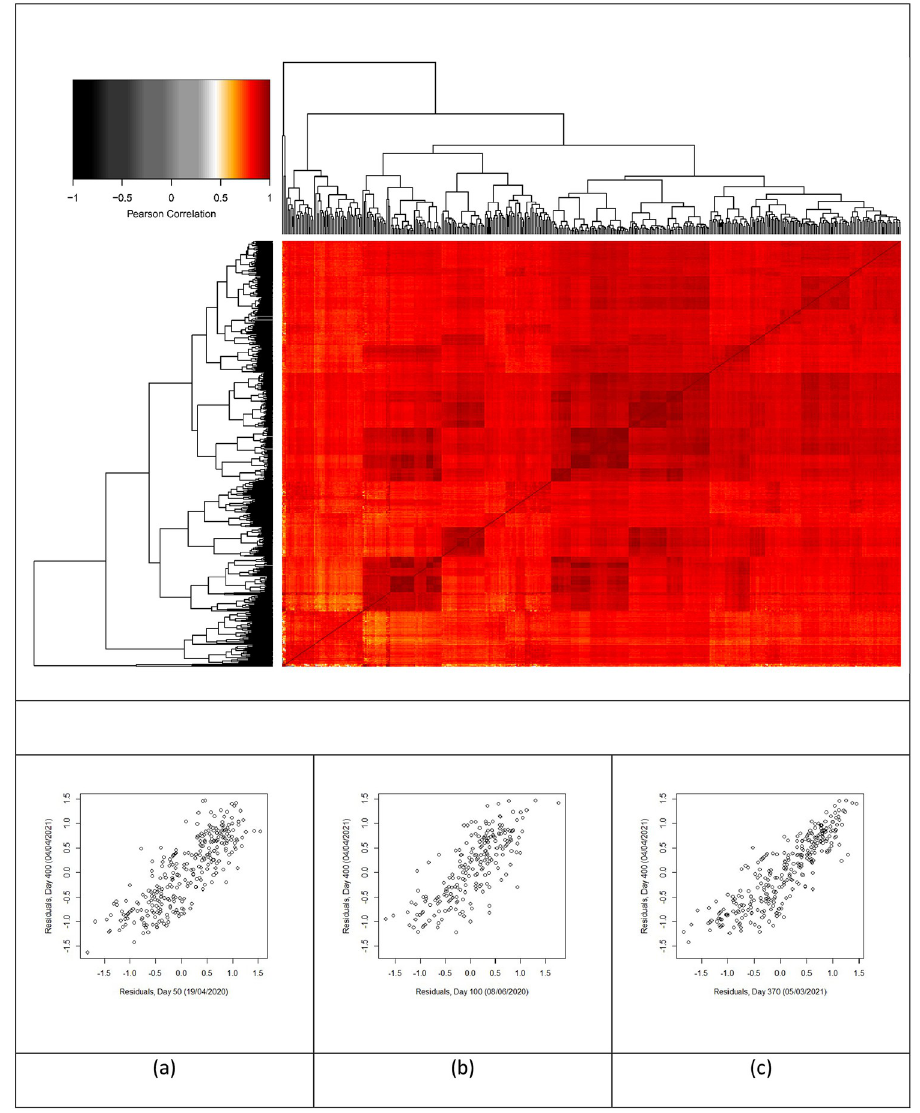
Fig 9. Heatmap of Pearson’s correlation coefficient with example paired dated. Correlation of COVID-19 case residuals between all pairs of dates between 01/03/2020 and 20/05/2021 (main panel). Red indicates strong positive correlation. White and grayscale indicate low and negative correlation. The darker shade of colour is associated with a higher similarity between the two pairs. Example data sets where residuals from days 50 (a), 100 (b), and 370 (c) are correlated with those from day